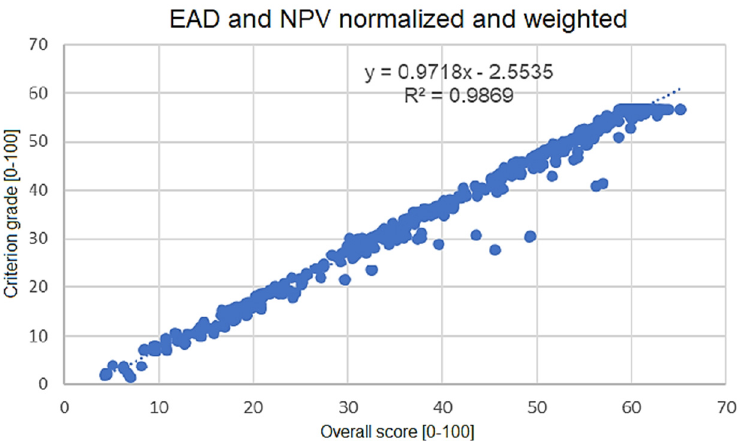
Figure 9. Dispersion of scores relating to the accumulated depreciation and benefit criteria weighted against global scores [authors].